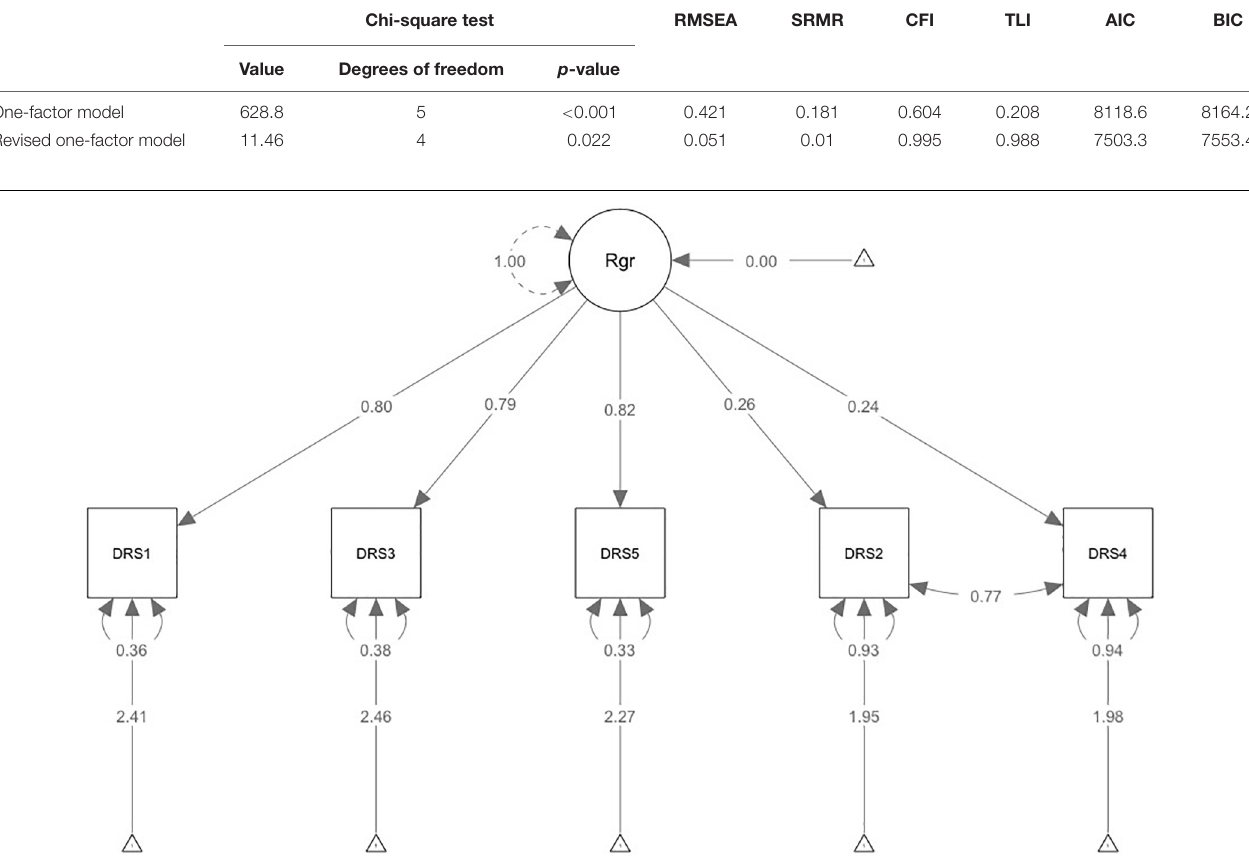
FIGURE 1 | Confirmatory factor analysis model with standardized path coefficients.